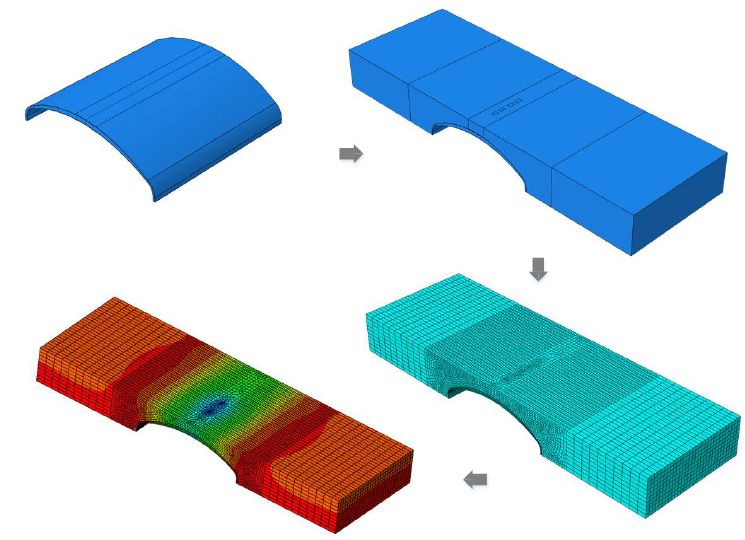
Figure 10. Finite element model of the culvert bridge.